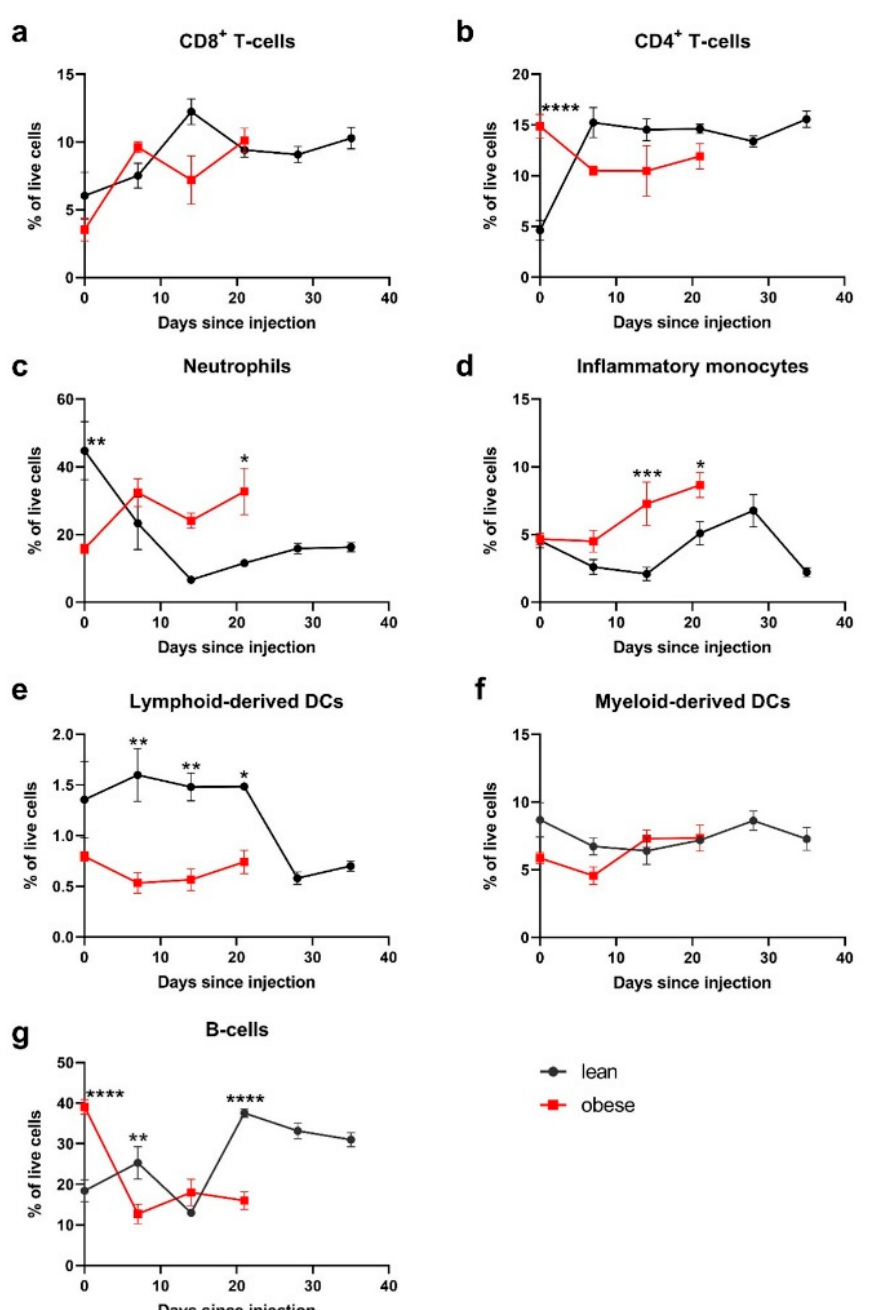
Figure 6. Analysis of immune cell populations in the blood of tumour-bearing mice. Lean and obese mice were tail-tipped every 7 days following MC38 cell engraftment and cells were analysed by flow cytometry for ( a ) CD8 + T cells; ( b ) CD4 + T cells; ( c ) neutrophils; ( d ) inflammatory monocytes; ( e ) lymphoid-derived DCs; ( f ) myeloid-derived DCs and ( g ) B-cells. Data are the mean ± STD from n = 5 mice/group. Statistical significance was determined using a two-way ANOVA followed by Sidak’s multiple comparison. * p < 0.05, ** p < 0.01, *** p < 0.001, **** p < 0.0001.